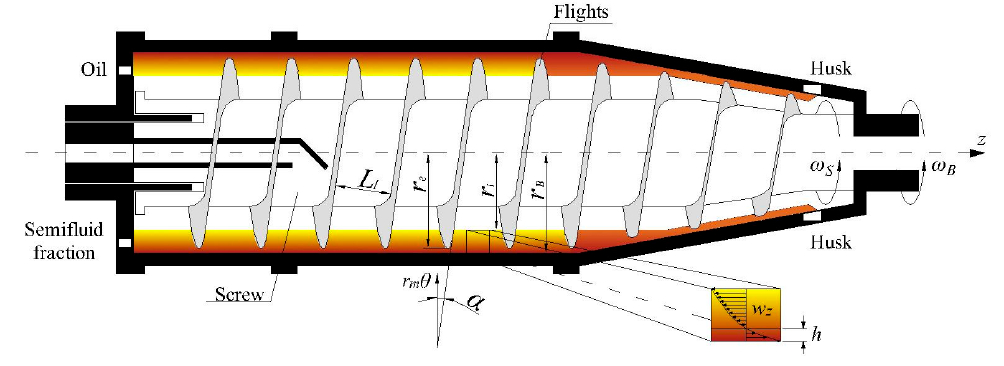
Figure 1. Scheme of the horizontal decanter system used.